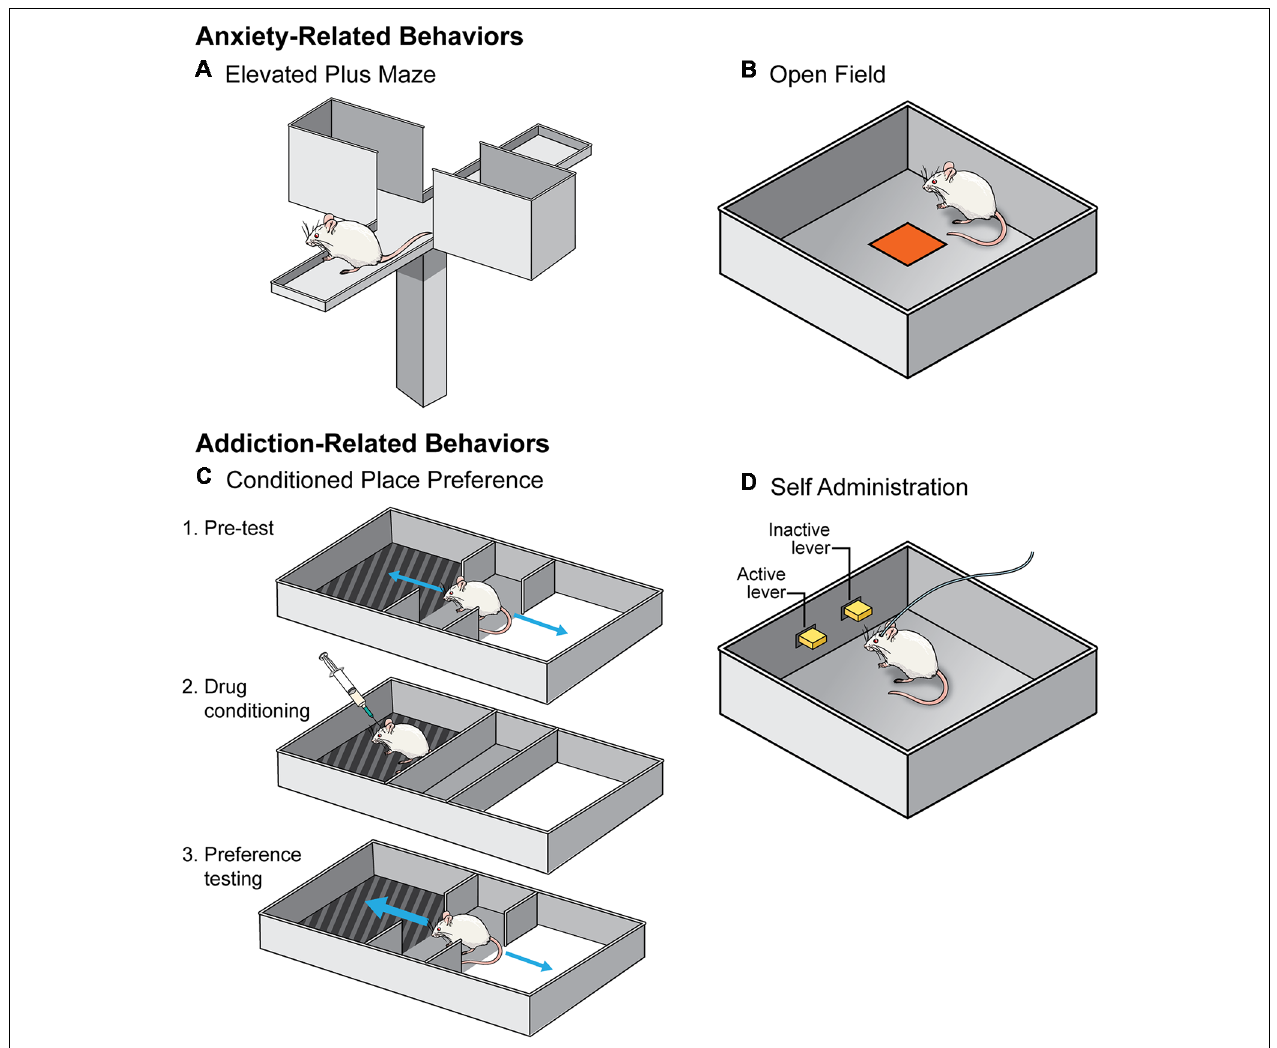
FIGURE 2 | A schematic of the behavioral tests utilized to assess the effects of social isolation rearing on anxiety- (top) and addiction- (bottom) related behaviors. (A,B) Anxiety-related behavioral tests include elevated plus maze (A) and open field (B) . An animal is considered less anxious if they spend more time in the open arm of an elevated plus maze and the center of an open field. (C,D) Addiction-related behavioral tests include conditioned place preference (CPP; C ) and self-administration (SA; D ). An animal who forms a preference for the side of a chamber where they received a drug in CPP is considered to find that drug more rewarding (C) . In SA paradigms (D) , animals learn that pressing the active lever but not the inactive lever results in an injection of a drug of abuse. Animals are thought to find drugs of abuse more rewarding if they learn the operant task more quickly.